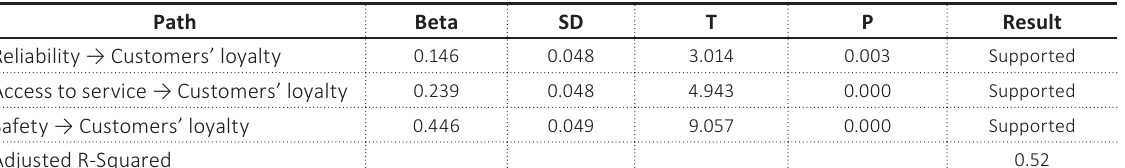
Figure 3. Structural equation modeling Table 7. Hypotheses